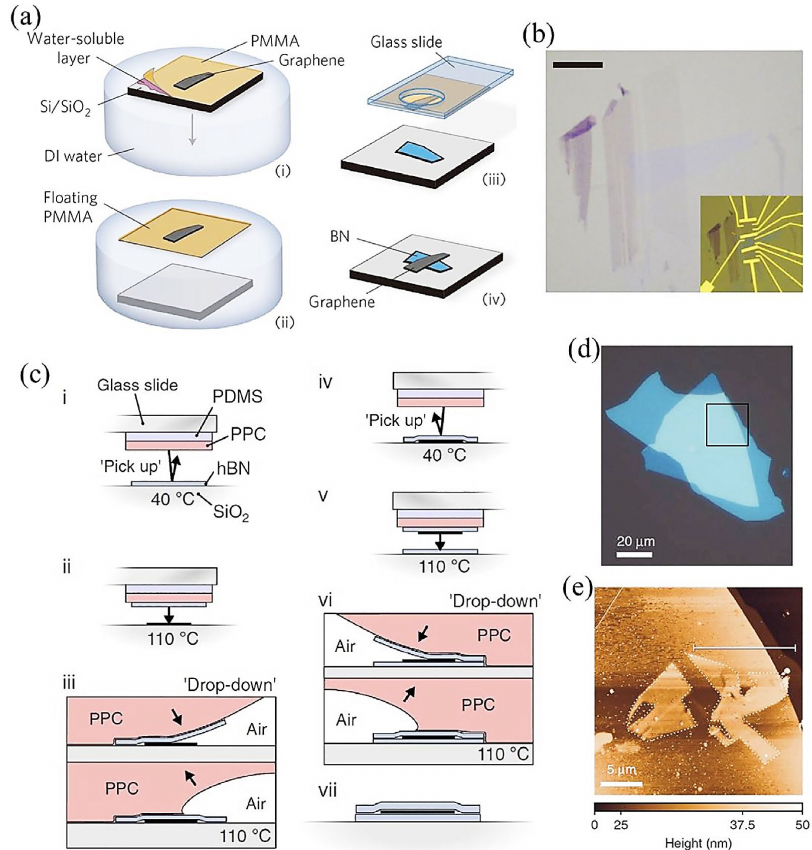
Figure 7. ( a ) Graphic representation of transfer approach utilized to produce devices using graphene on h -BN. ( b ) Optical photograph for graphene on h -BN (after performing the transfer). The inset shows electrical connections. Adapted with permission from Ref. [70]. Copyright 2010, Nature Publishing Group. ( c ) Schematics of pick-up and drop-down flow process for assembly of 2D heterostructures showing that flakes can be dropped-down and picked-up at the preferable positions. ( d ) Optical microscopic photograph of a staked graphene sandwiched among h -BN flakes after the procedure shown in ( c ). ( e ) The AFM of the stacks show no optically visible blisters of contaminations. Adapted with permission from Ref. [110]. Copyright 2016, Nature Publishing